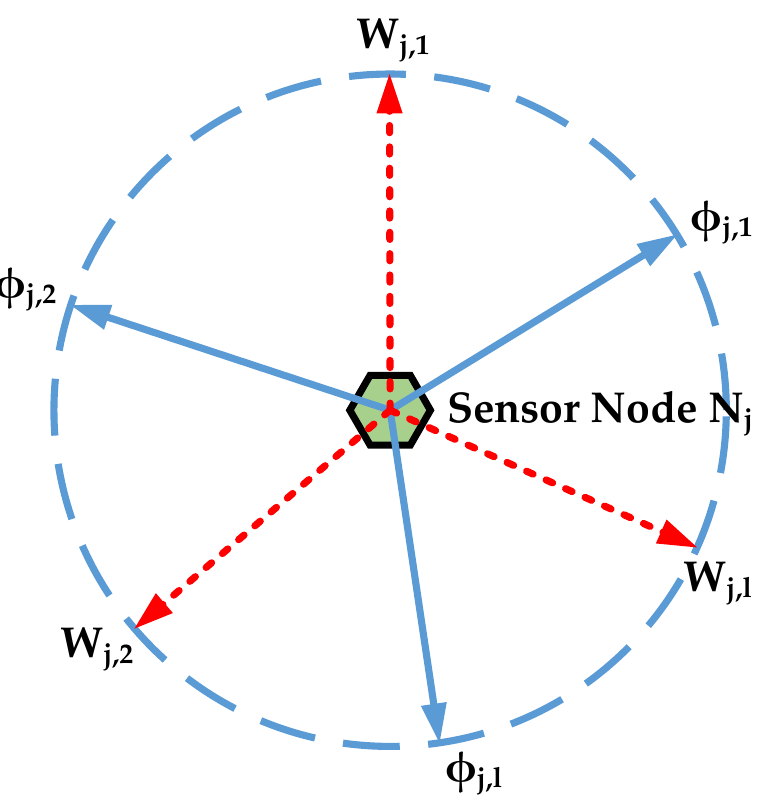
Figure 3. The location relationship between sensor azimuths and boundary constraint of the same